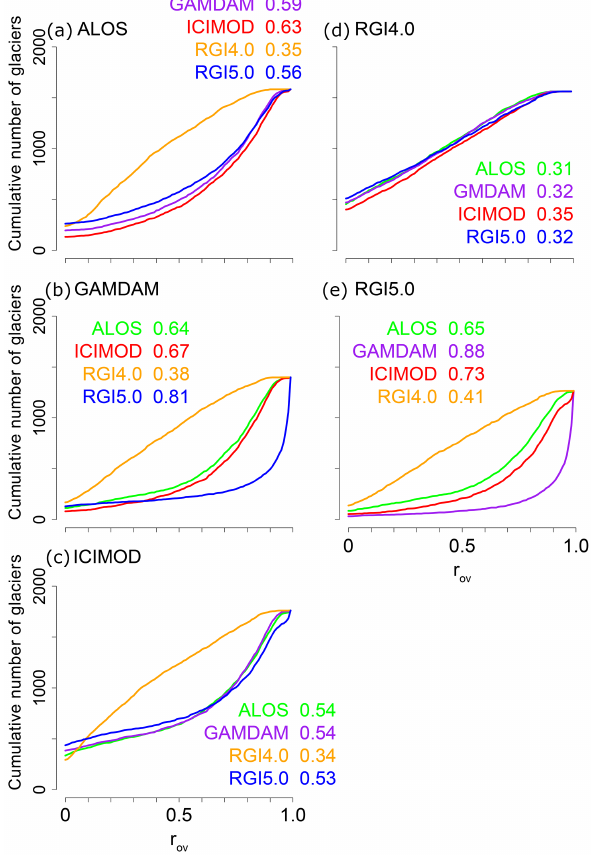
Figure 15. Cumulative glacier numbers against overlap ratios ( r ov ) for the six glacier inventories covering the Bhutan Himalaya. Glacier number increases from the lower r ov to the higher r ov , where a constant increase means a large number of low- r ov outlines, and a later high rate of increase means a large number of high- r ov outlines. Mean r ov values for each combination are denoted in the